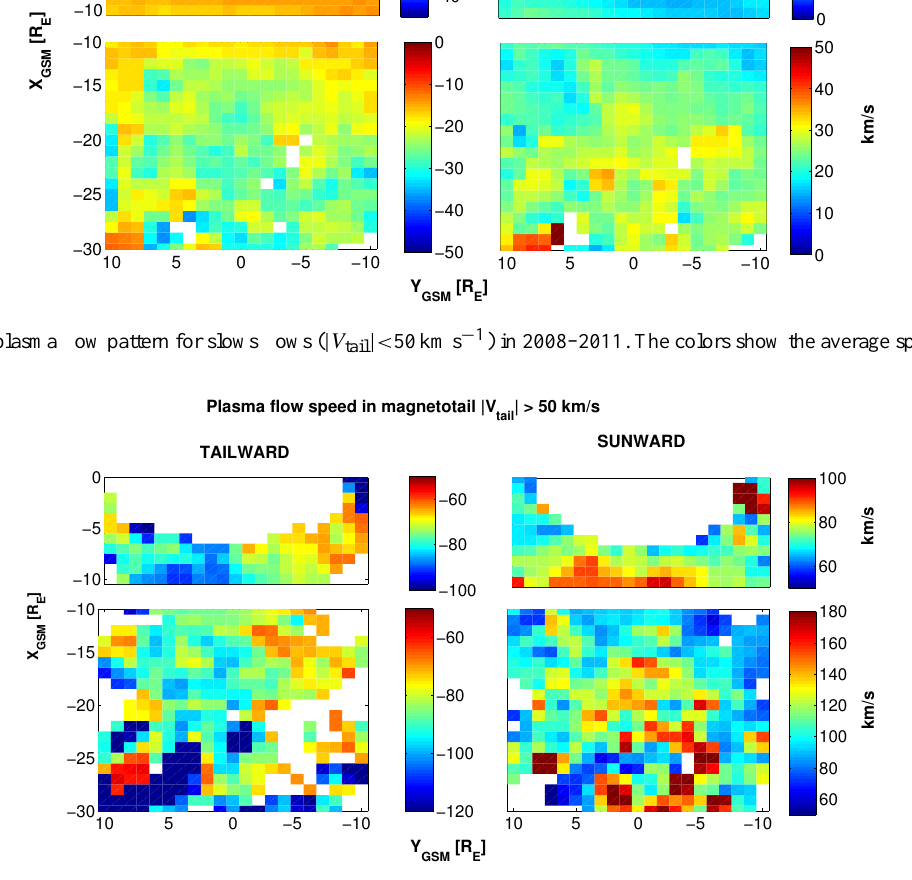
Figure 2. Average plasma flow pattern for fast flows ( | V tail | > 50kms − 1 ) in 2008–2011. The colors show the average speed of the